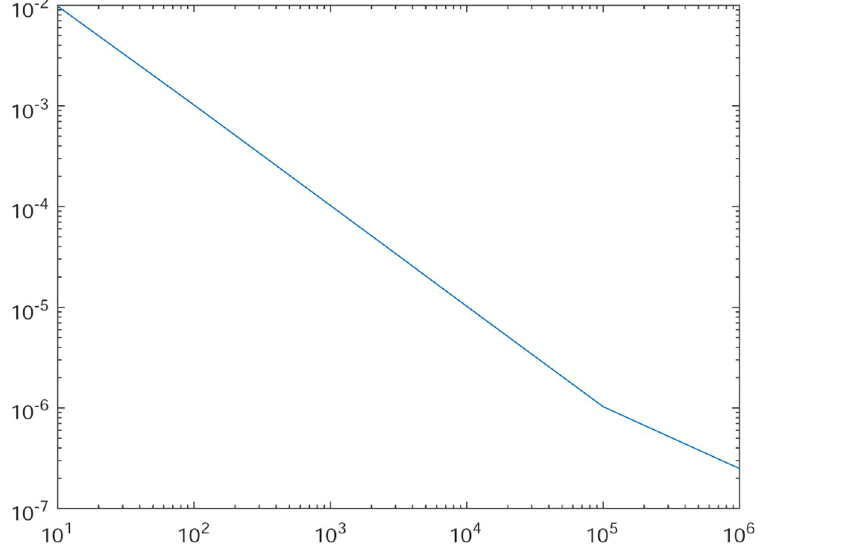
Fig 1. The behavior of the error with respect to the parameter θ for the Experiment 1.